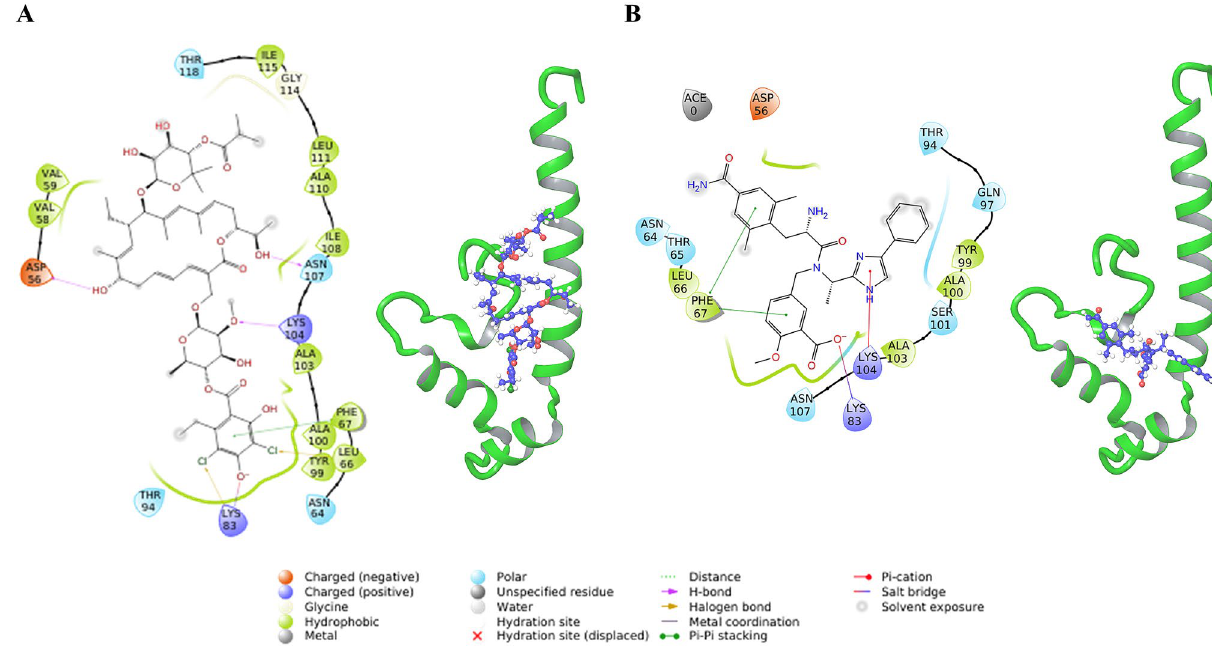
Figure 4. Interactions of ligands in XP-pose with IFITM3 ( A ) Fidaxomicin ( B )